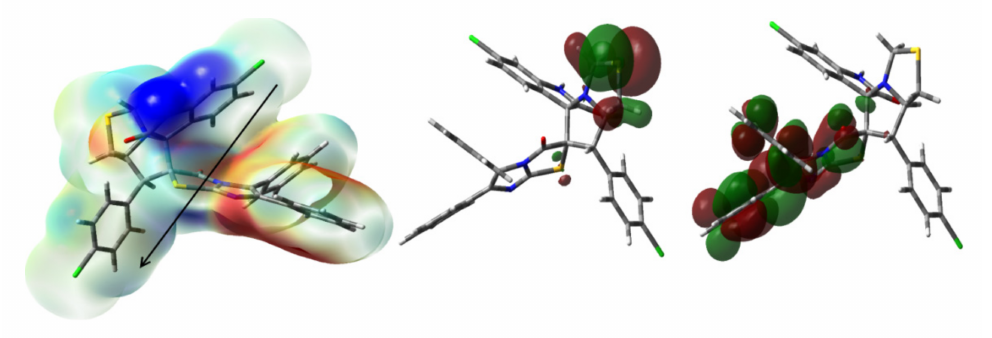
Figure 10. The MEP, HOMO and LUMO of 4 . Black arrow indicates the direction of the dipole moment